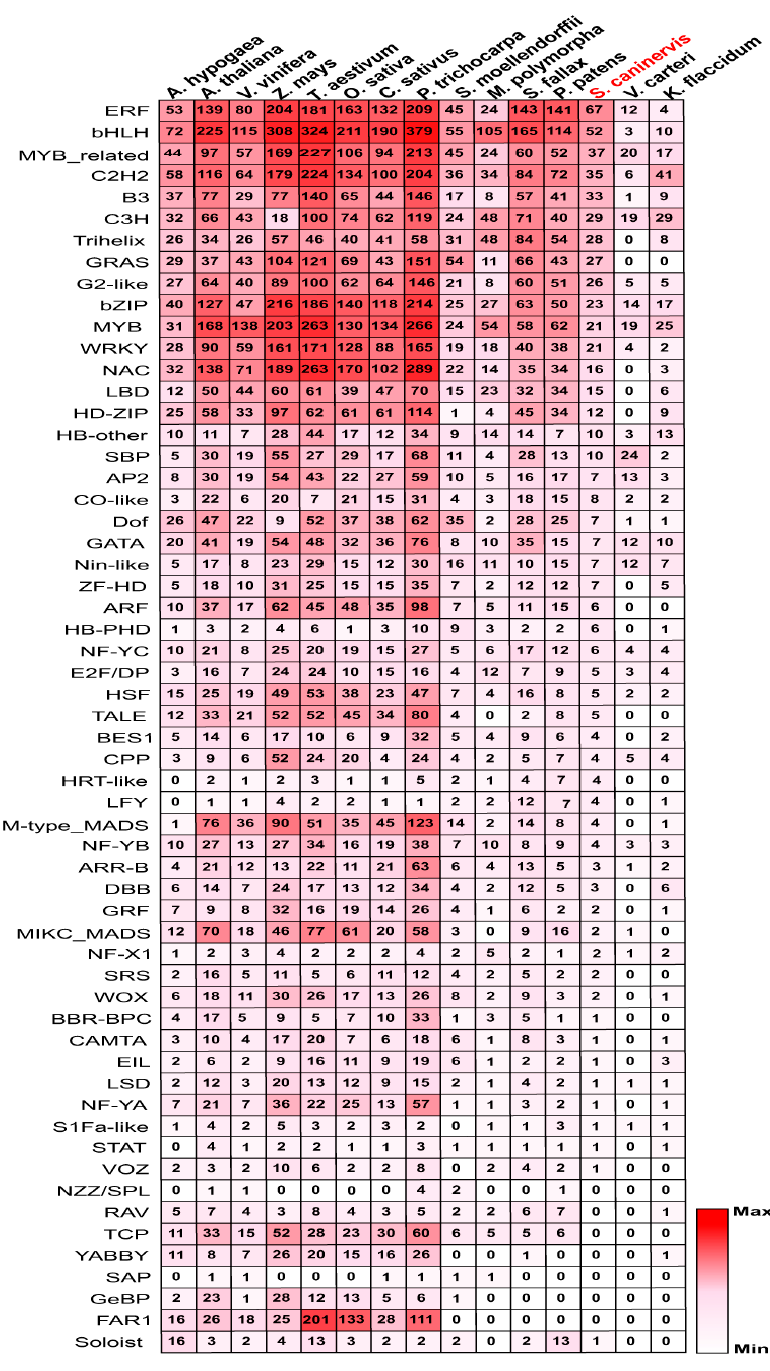
Figure 1. A list of different members of 591 TF families was observed in 14 represented plant species. The red color indicated the maximum number of TFs in different plant species. S. caninervis was labeled in red color.